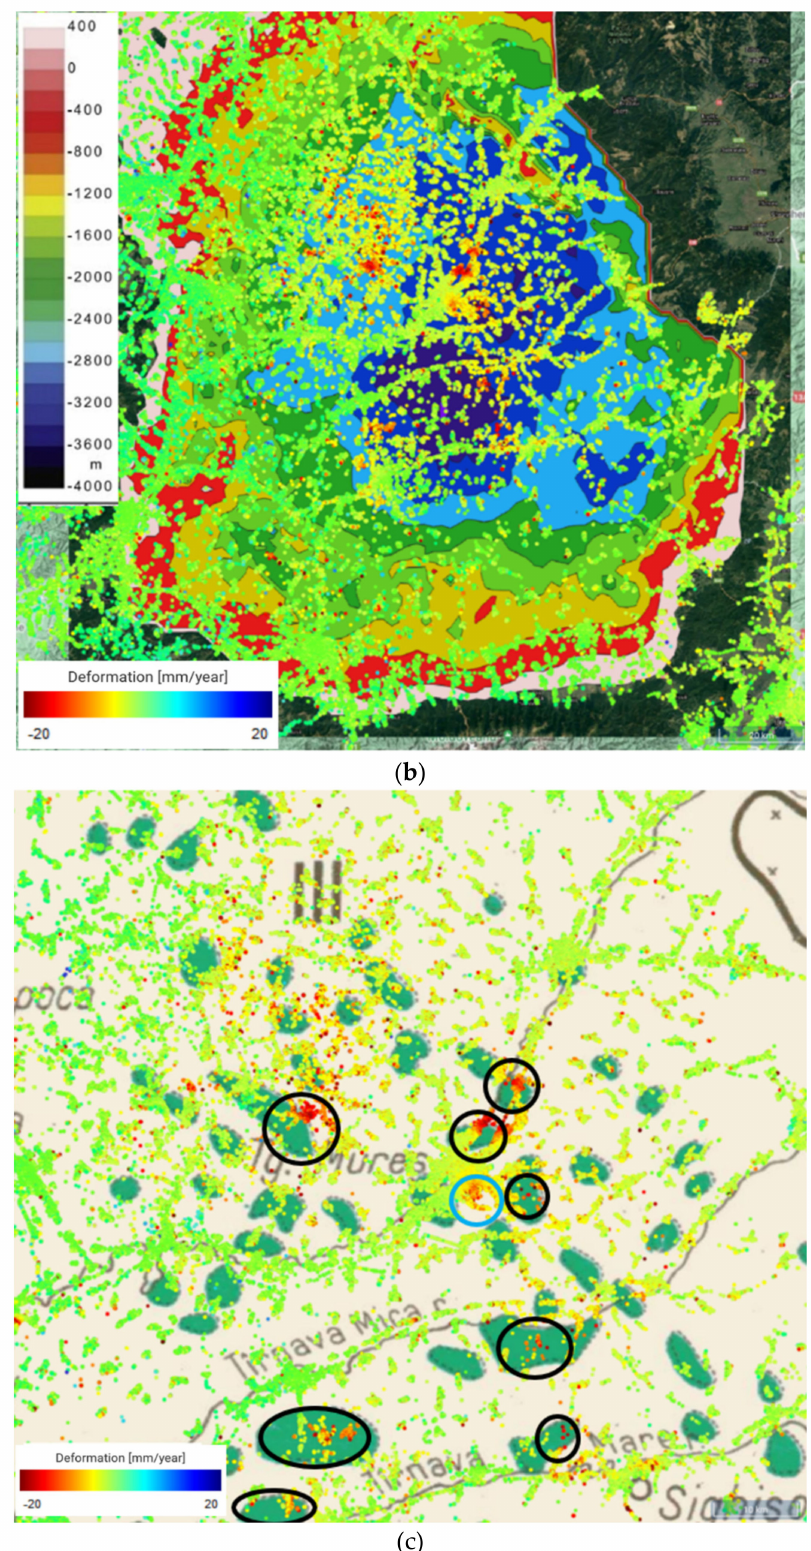
Figure 16. Subsidence areas in central Transylvania: ( a ) subsidence measured with PSInSAR; ( b ) salt diapirs—color contours (from modified from [21]) illustrate the depth of the salt below surface; ( c ) gas extraction fields marked with black